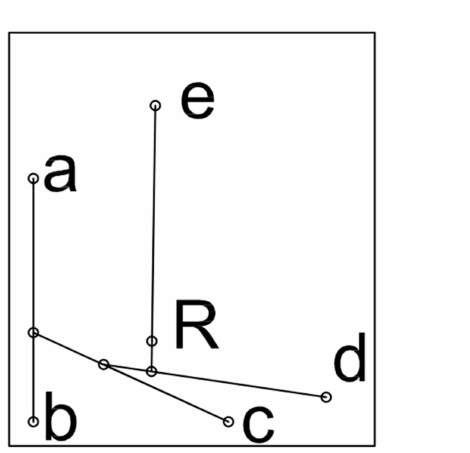
Figure 4. Calculation of the resulting force exerted by Aligner 2 on the vestibular surface of the tooth. The letters a, b, c, d, e, respectively indicate the points of application of the forces exerted by the pressure areas A, B, C, D, E, while the letter R indicates the point of application of the resulting total force exerted by the aligner on the